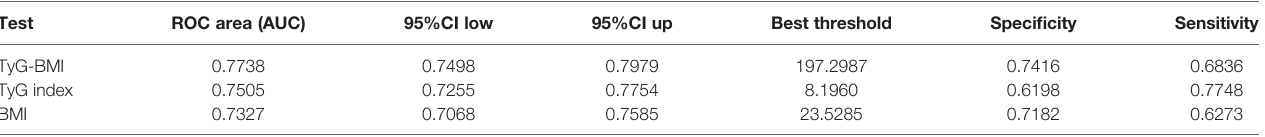
TABLE 4 | AUC with the 95% CI of TyG-BMI, TyG index and BMI for predicting incident